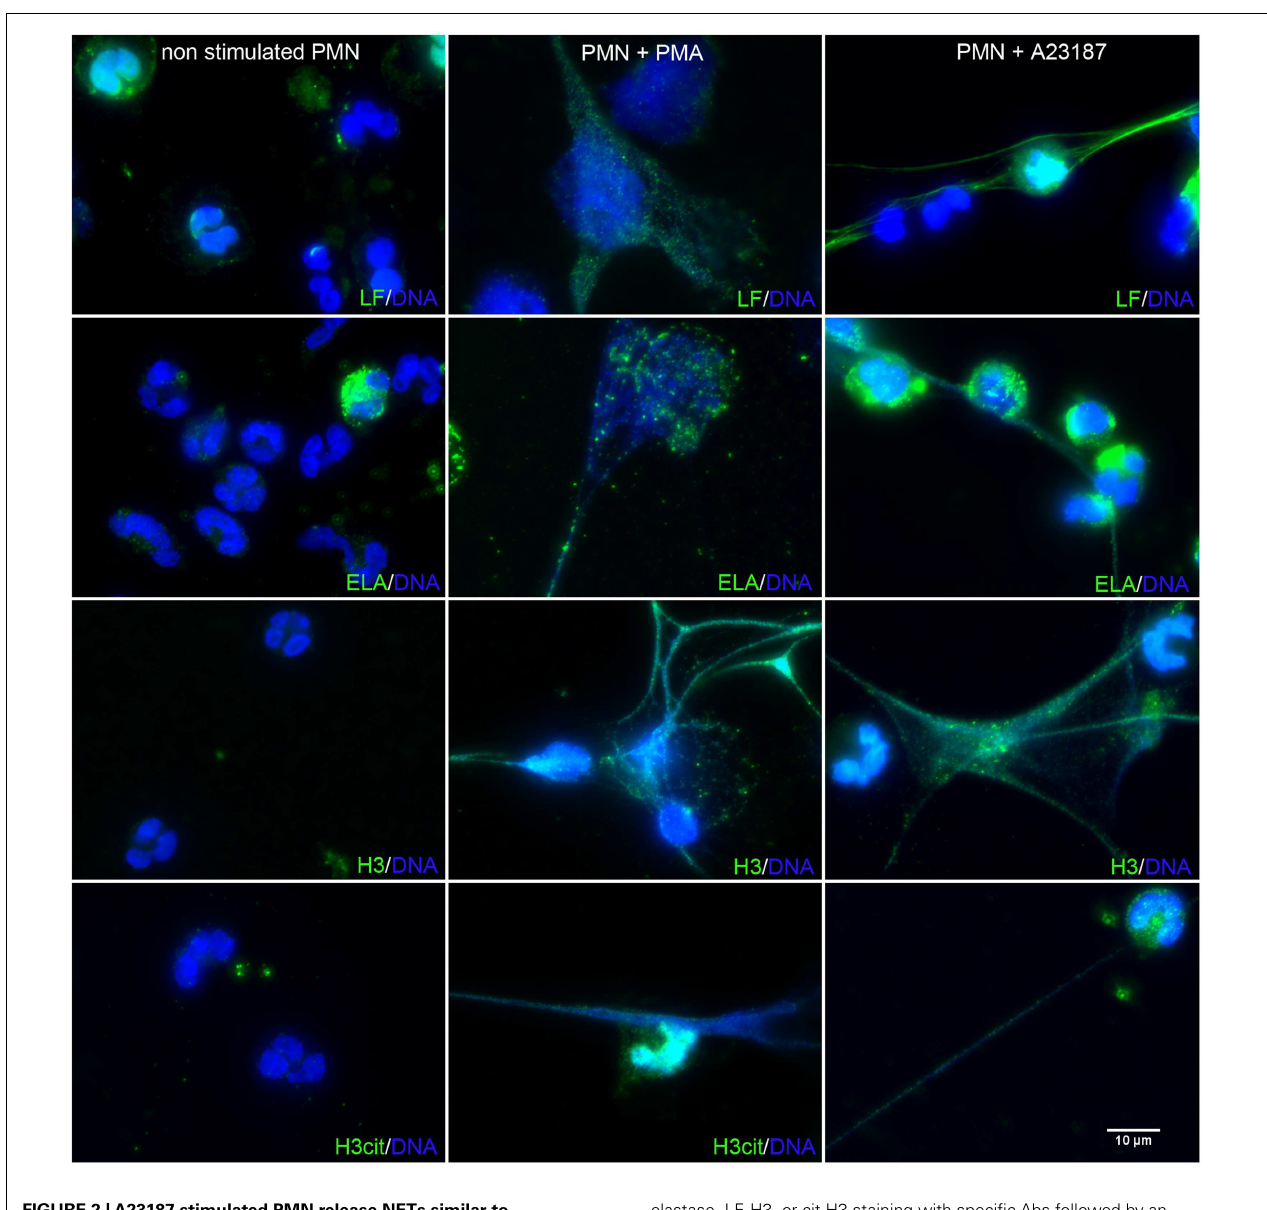
FIGURE 2 |A23187-stimulated PMN release NETs similar to those induced by PMA . PMN were treated with PMA (50nM) or A23187 (5 µ M) for 3h. NETs were observed by immunofluore scence microscopy after DNA staining with DAPI (blue), and after